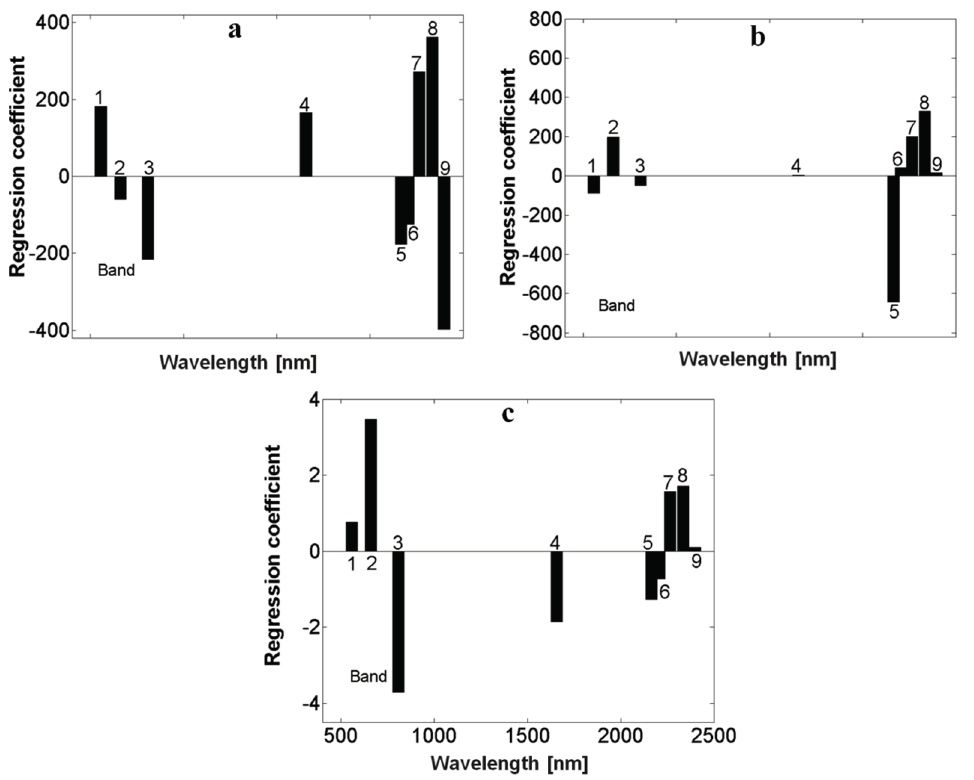
Figure 4. PLSR coefficients of the nine bands of ASTER data for: ( a ) soil salinity; ( b ) clay content; and ( c ) OM.